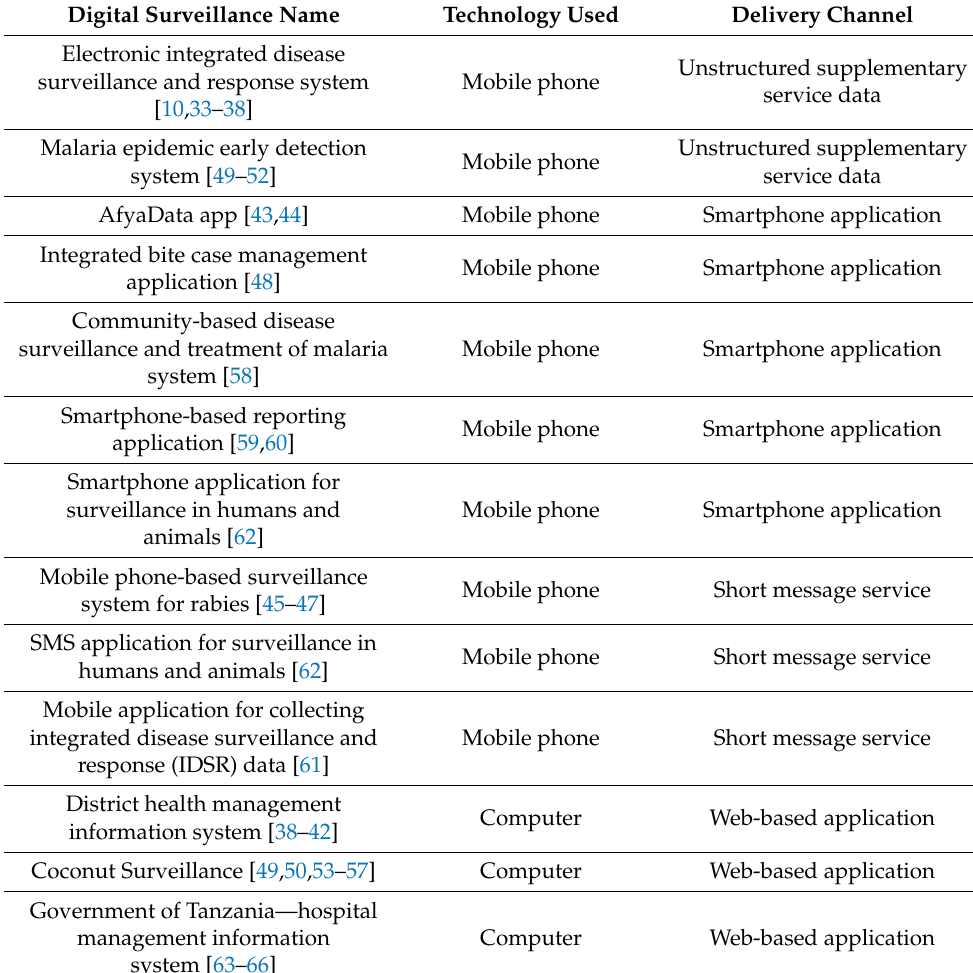
Table 3. Types of digital technologies identified from the literature